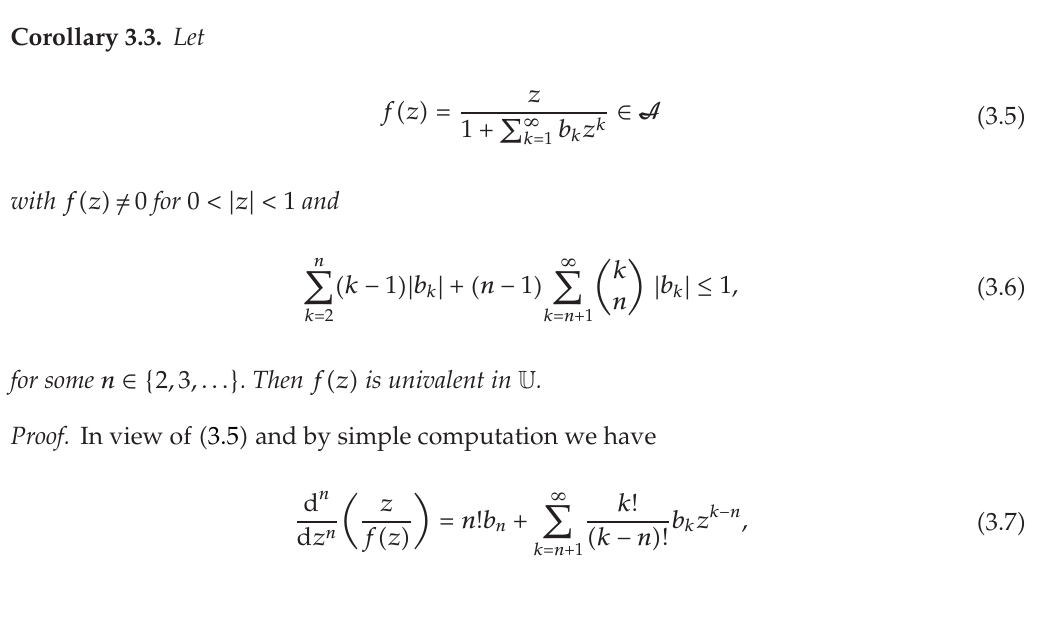
Figure 1 (cid:2) c (cid:3)